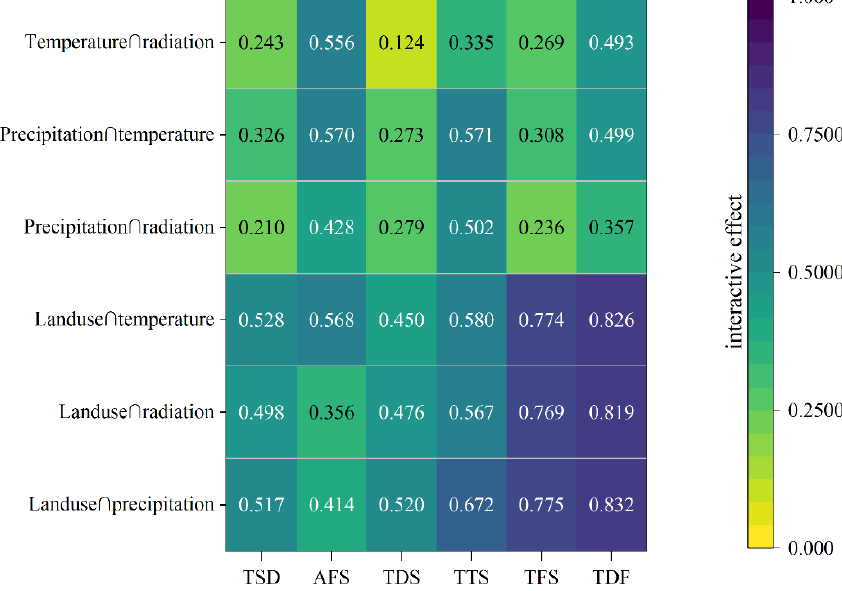
Figure 7. The interactive effects of climate factors and land use on the NPP on the LP.